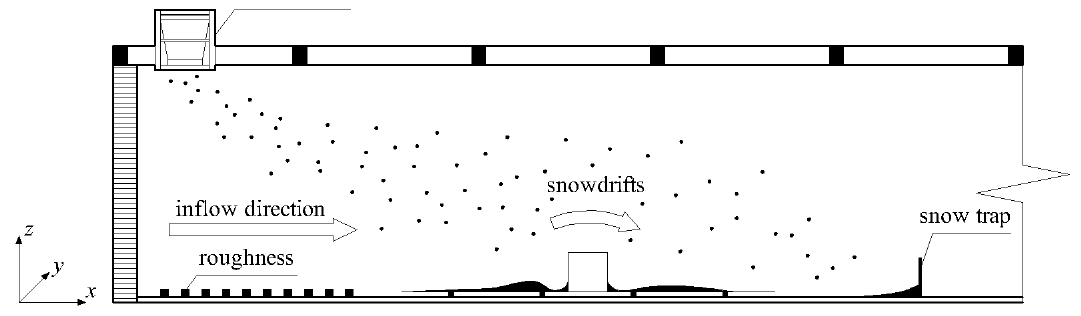
Figure 1. Schematic view of the experimental facility.